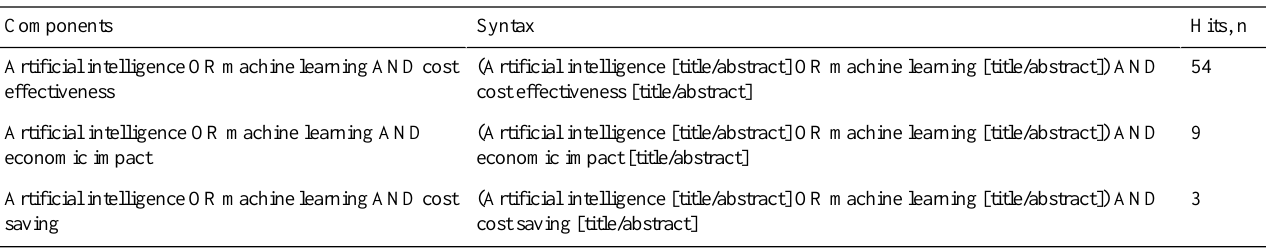
Table 1. Search terms (title and abstract) in the PubMed analysis (conducted on July 29,